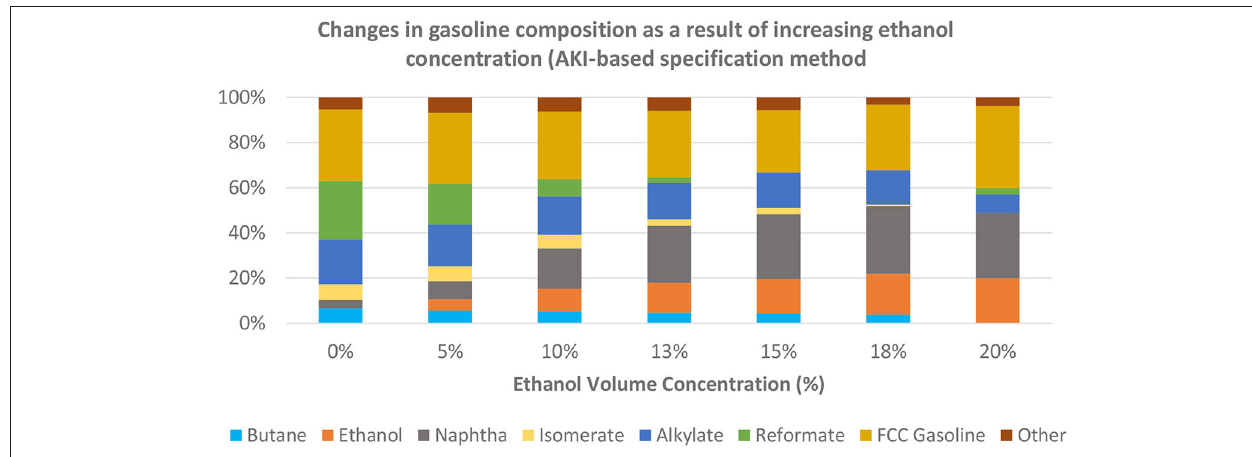
FIGURE 4 | Changes in gasoline composition as a result of increasing ethanol concentration.